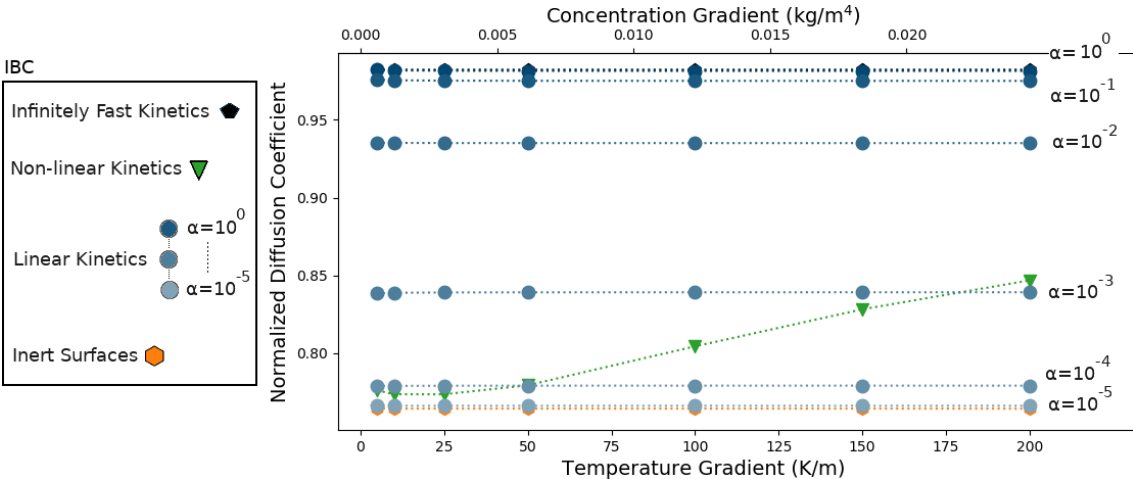
Figure 6. Normalized diffusion coefficients D norm with a DF snow microstructure for different temperature and vapor gradients, different eff IBCs, and a mean temperature of 258K. Note that the α = 1 and the infinitely fast kinetics cases are superimposed at the top of the graph and that the α = 10 − 5 and the inert-surface cases are indistinguishable at the bottom of the graph.